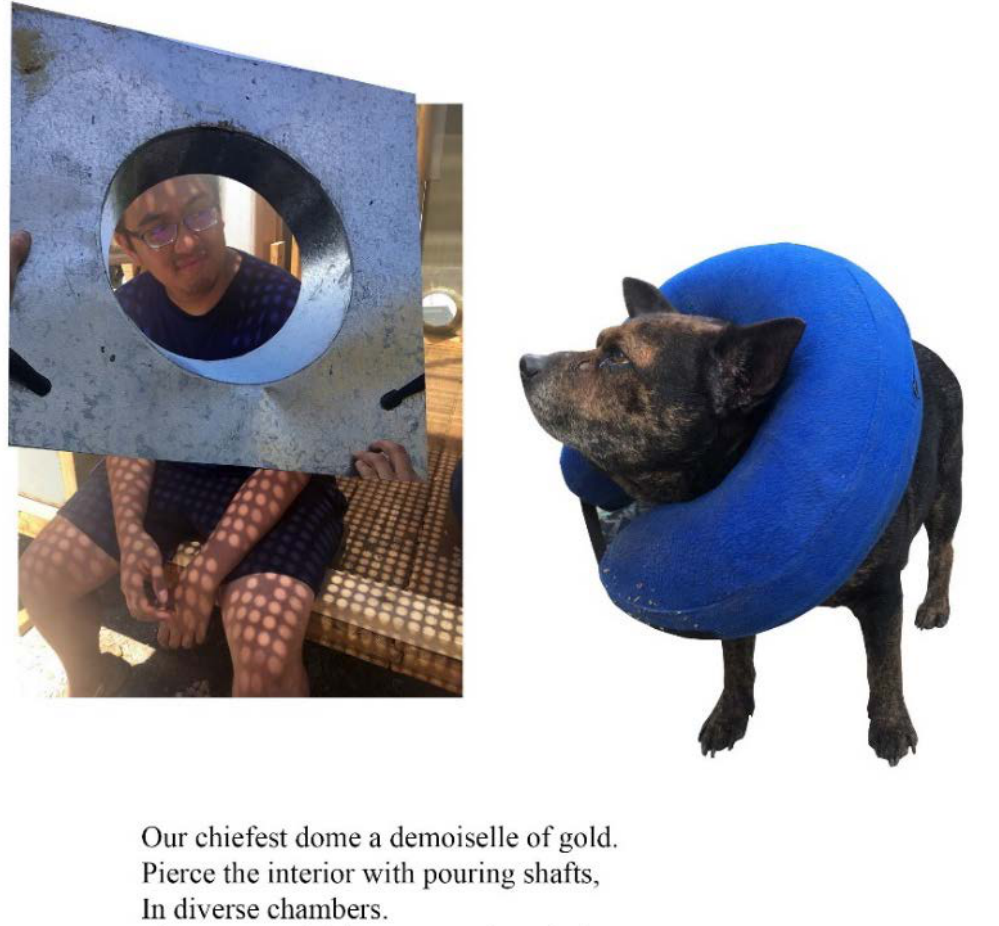
Figure 7. Vent Flashing and Donut Collar and Stevens (Photographs by Samantha Janolo), 2018.